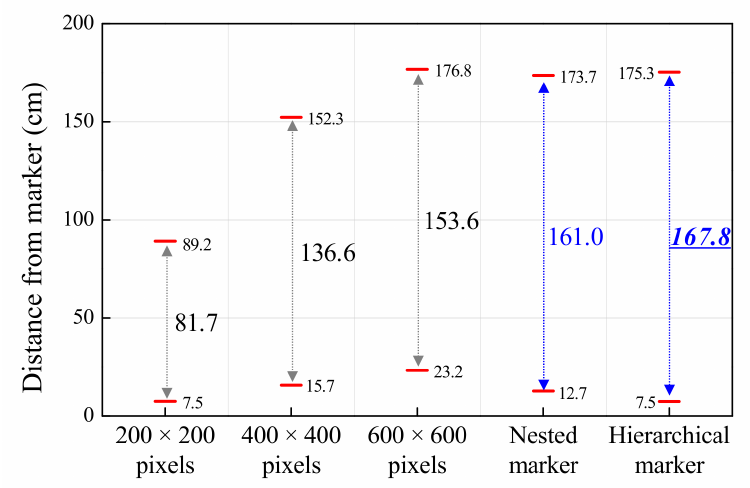
Figure 13. Recognition distances for different markers.